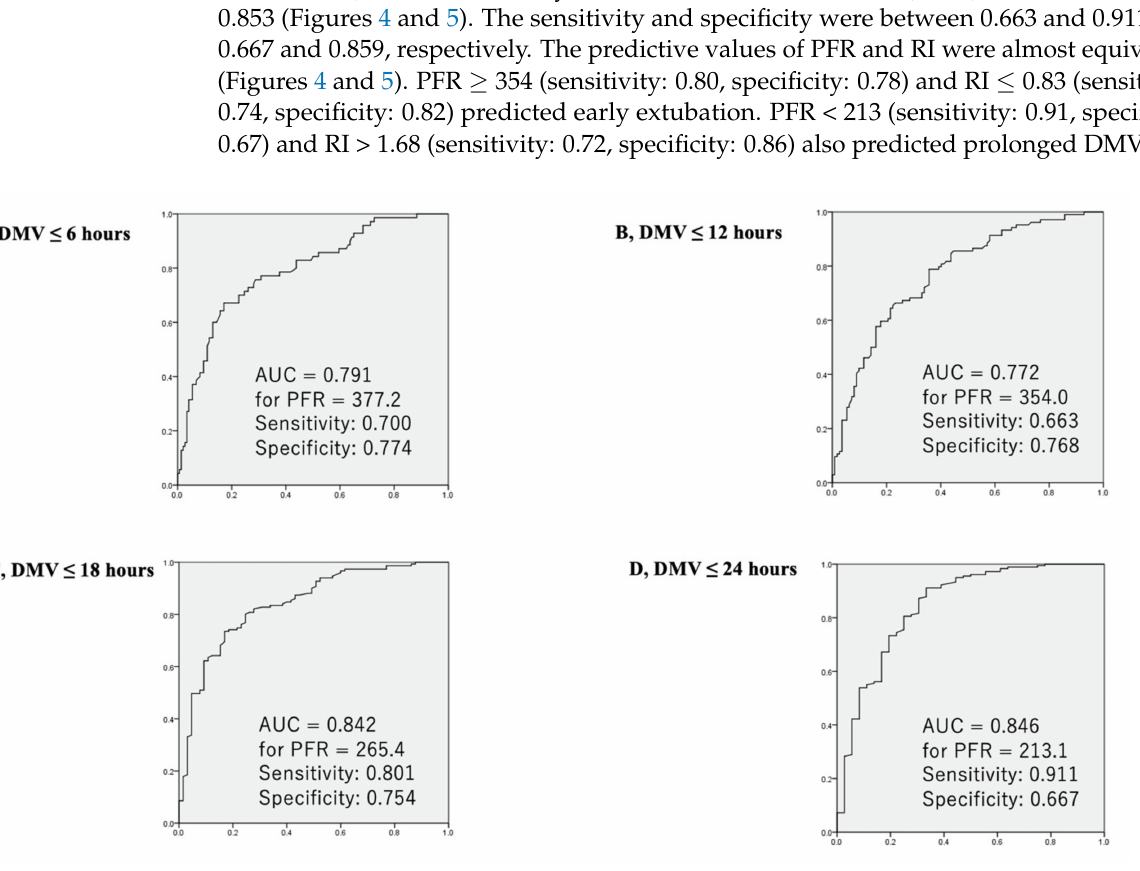
Figure 4. Receiver operating characteristic (ROC) curves for PaO 2 /FiO 2 (PFR) as a predictor of the duration of mechanical ventilation shorter than 6 h ( A ), 12 h ( B ), 18 h ( C ), and 24 h ( D ) are presented. ( A ) PFR > 377.2 showed the highest sensitivity (0.700) and specificity (0.774) with an area under the curve of 0.791. ( B ) PFR > 354.0 showed the highest sensitivity (0.663) and specificity (0.768) with an area under the curve of 0.772. ( C ) PFR > 265.4 showed the highest sensitivity (0.801) and specificity (0.754) with an area under the curve of 0.842. ( D ) PFR > 213.1 showed the highest sensitivity (0.911) and specificity (0.667) with an area under the curve of